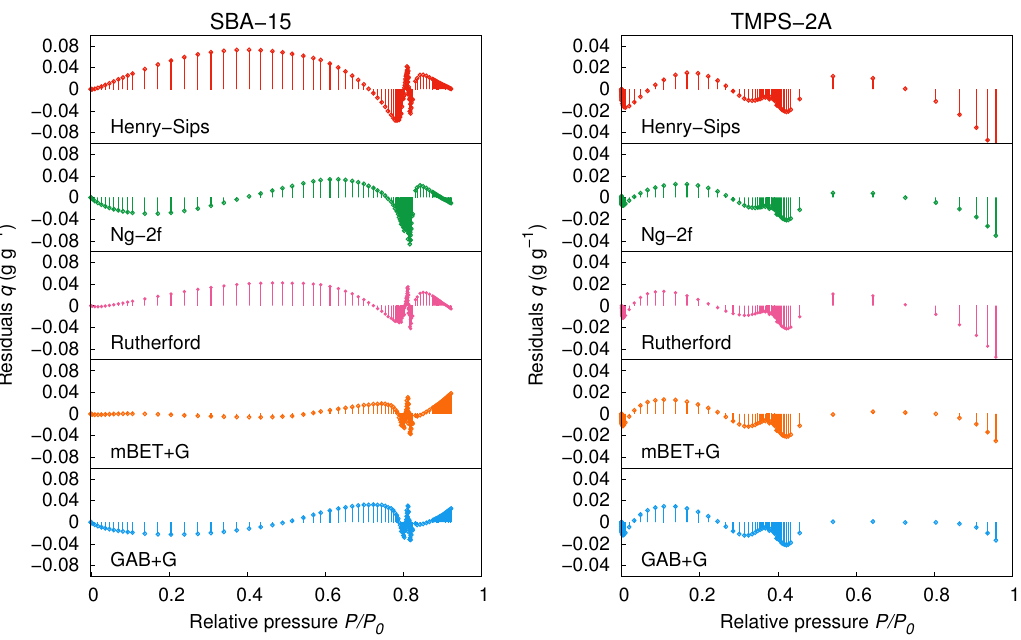
Figure 4. Residual analysis of the models fitting (SBA-15: 20 ◦ C, TMPS-2A: 25 ◦ C).